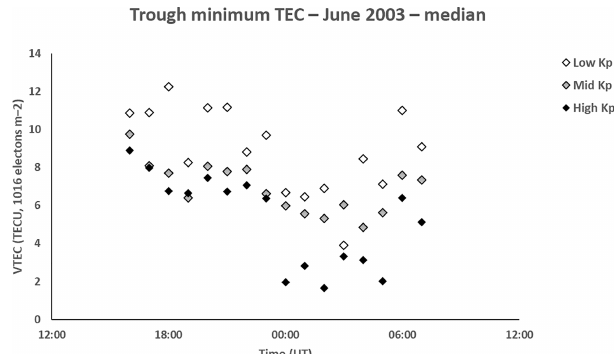
Figure 11. Median VTEC for the trough minimum in June 2003 from 16:00 to 07:00UT for low Kp (0 to 2 + ) , medium Kp (3 − to 4) and high Kp ( ≥ 4 + ) . The representative interquartile range is approximately 2.5 TECU. The VTEC values are clearly larger than for the prominent trough considered for the main study, apart from between 00:00 and 05:00UT for high